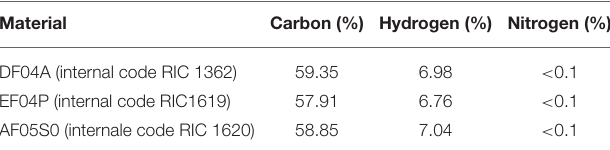
TABLE 3 | Mater-Bi elemental composition. Material